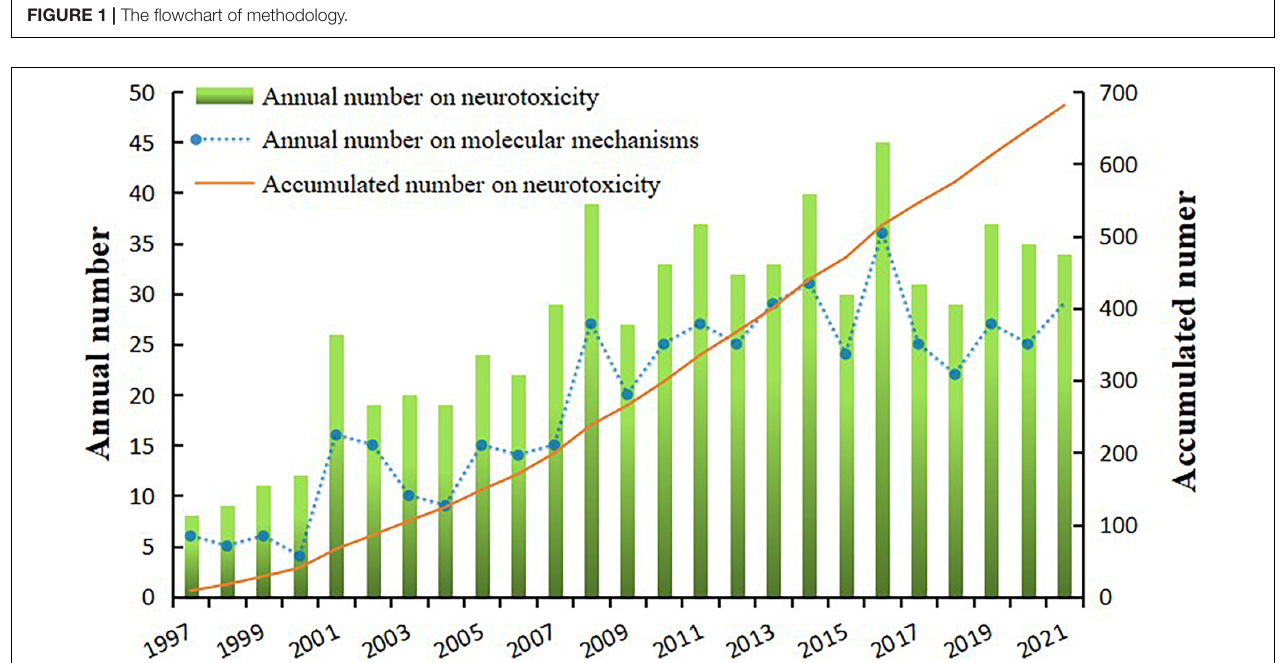
FIGURE 2 | Annual number and accumulated number of articles on neurotoxicity of substance abuse, and number of publications on molecular mechanisms from 1997 to 2021.